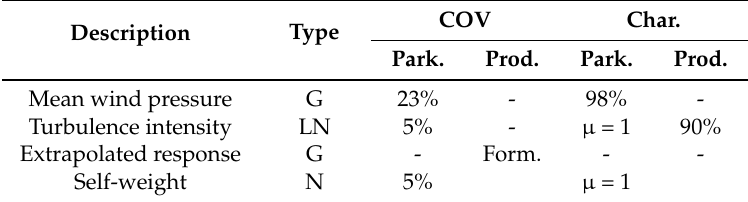
Table 5. Physical uncertainties from [18].